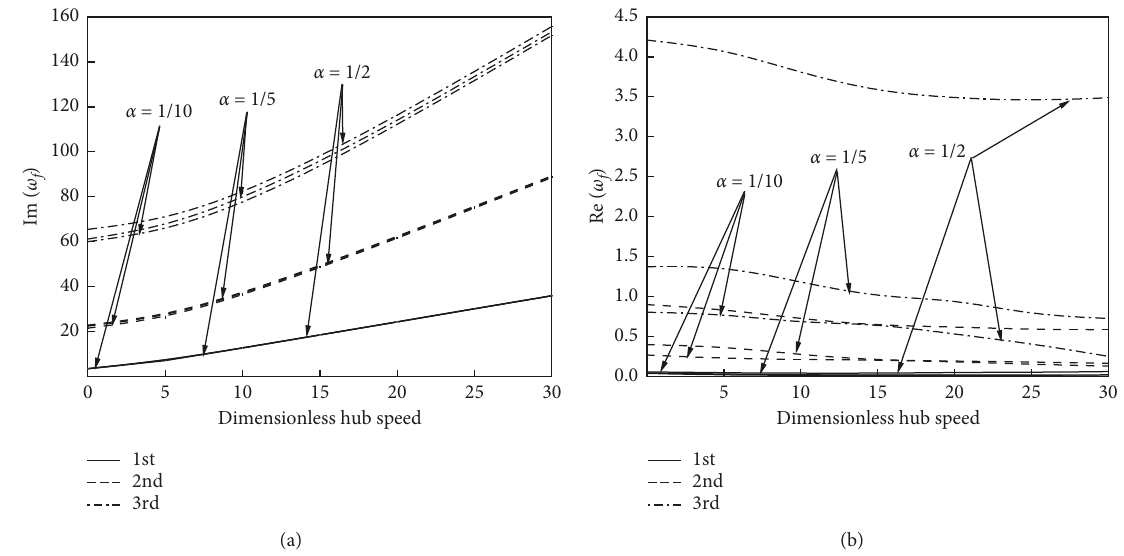
Figure 6: Variation curves of complex frequency of the systems at dimensionless hub speed with different fractional order at r r � 1/30, and g � 0 .